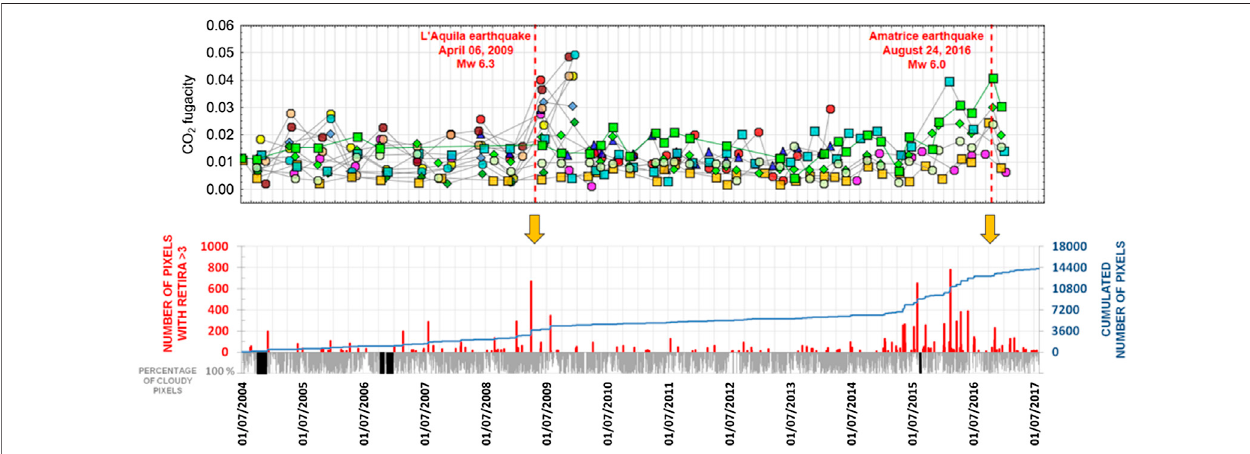
FIGURE 4 | Comparison between time variations of P CO2 (fugacity) values in water samples from ARPA network (upper box), and TIR anomalies (lower box). Red dotted lines and yellow arrows indicate the two major seismic events (2009 and 2016) occurred during the 2004 – 2017 observation period. In the lower box, red bars report the number of pixels with ⊗ Δ T ( x , y , t ) > 3.0, and the blue line the cumulated number of anomalous pixels. Gray bars indicate the percentage of cloudy pixels over the investigated area, and black boxes periods of missing satellite